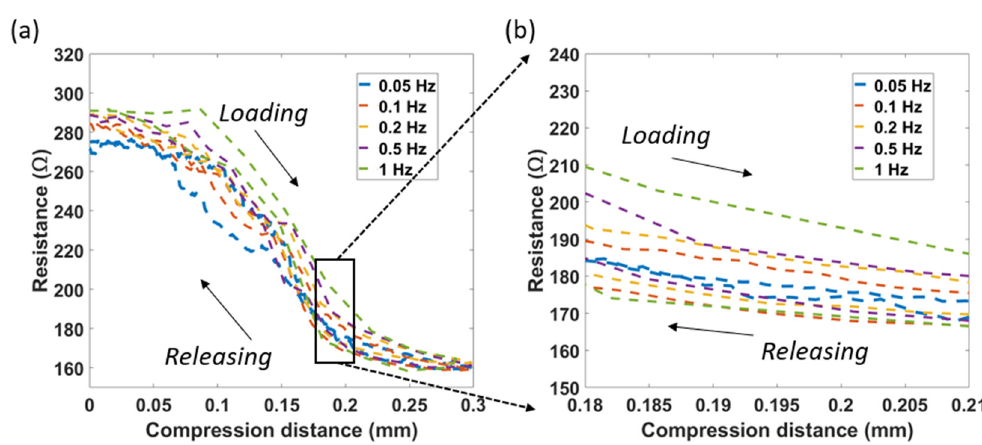
Figure 6. ( a ) Hysteresis at different frequencies in the compression from 0 – 0.1 mm, and ( b ) hysteresis at different frequencies in the compression from 0.06 - 0.07 mm.